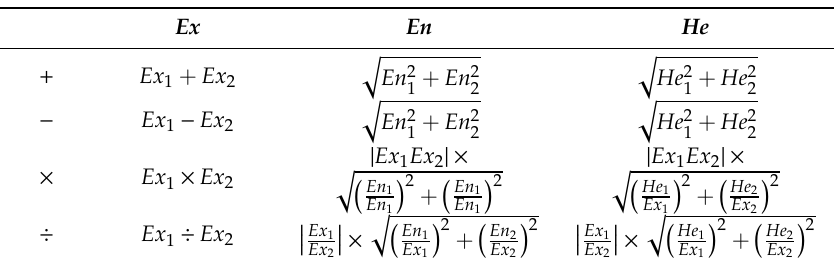
Table 1. Computing rules of the uncertainty transformation model.